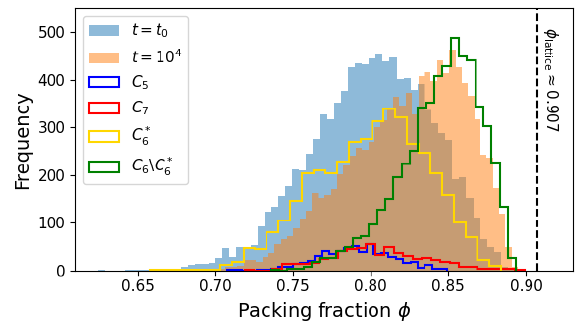
Figure 3: The filled histograms are packing fractions φ of maximum inscribed disks in the Voronoi landscapes at step t = t 0 and t = 10 4 of a single realisation of Poisson-PP (cid:105) = 0 . 800 and (cid:104) φ (cid:105) = 0 . 824. with the mean values (cid:104) φ t = t t = 10 4 0 For t = 10 4 , we consider defective cells denoted by C n ( n = 5 , 7), highly distorted hexagons C ∗ , which make up 6 the first shell of neighbours to the defective cells, and the remaining hexagons C 6 \ C ∗ . The mean value of packing 6 fraction for each cell type is (cid:104) φ ( C 5 ) (cid:105) = 0 . 791, (cid:104) φ ( C 7 ) (cid:105) = 0 . 805, (cid:104) φ ( C ∗ ) (cid:105) = 0 . 800 and (cid:104) φ ( C 6 \ C ∗ ) (cid:105) = 0 . 845. 6 6